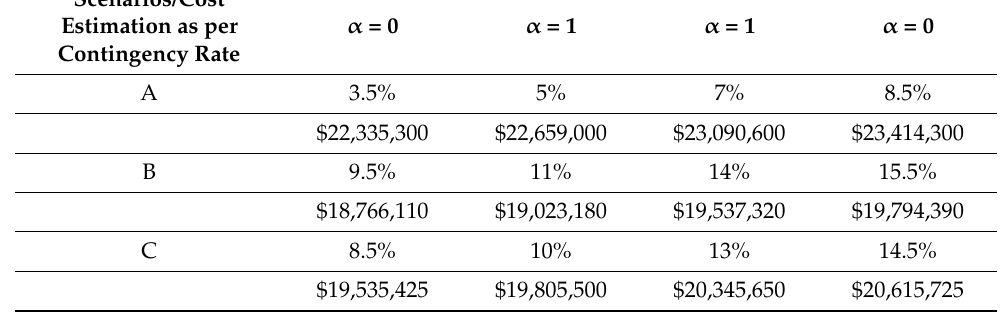
Table 8. Fuzzified cost estimation included in the range of contingency costs.